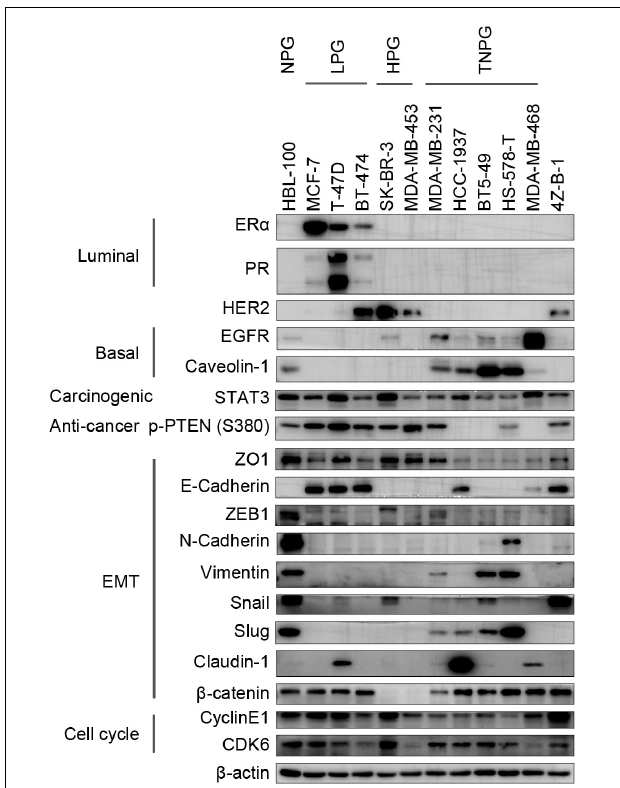
FIGURE 6 | Gene expression analysis of the 4Z-B-1 cell line. Protein expression pattern in the 4Z-B-1 cell line compared with the normal, luminal, HER2-positive and triple-negative phenotype breast cancer cell line